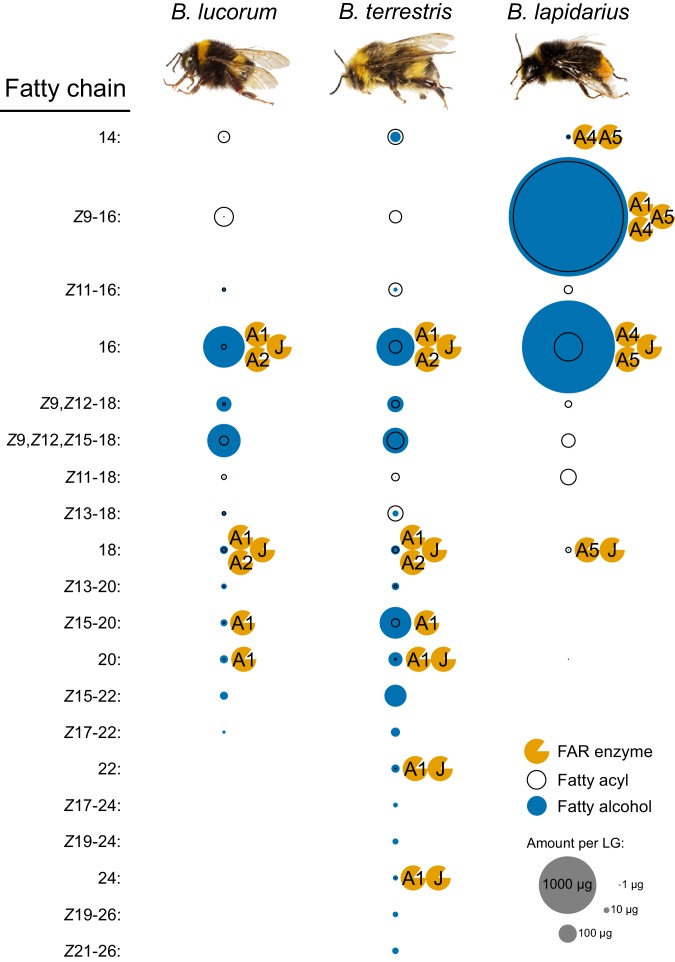
Fatty alcohols and fatty acyls of bumble bee male LGs together with the proposed participation of FARs in biosynthesis.The fatty alcohols and fatty acyls (determined as methyl esters) were extracted from LGs of 3-day-old males of B. lucorum, B. terrestris and B. lapidarius (N = 3) and quantified by GC. The area (size) of fatty alcohol and fatty acyl circle represents the mean quantity per a single male LG (Figure 5—source data 1). The FARs which could be involved in the fatty alcohol biosynthesis based on their specificity are appended to the left side of the corresponding fatty alcohol circle.10.7554/eLife.39231.021Figure 5—source data 1.List of fatty alcohol and fatty acyl quantities in LGs and FBs of bumble bee males.The file contains a list of quantified fatty alcohols and fatty acyl methyl esters (transesterifiable fatty acyls) in male LGs and FBs of 3-day-old B. terrestris, B. lucorum and B. lapidarius. In the case of 22:1 alcohols in FB of B. terrestris, the assignment of individual isomers was not possible due to their low amount, so they are reported as a sum of isomers.